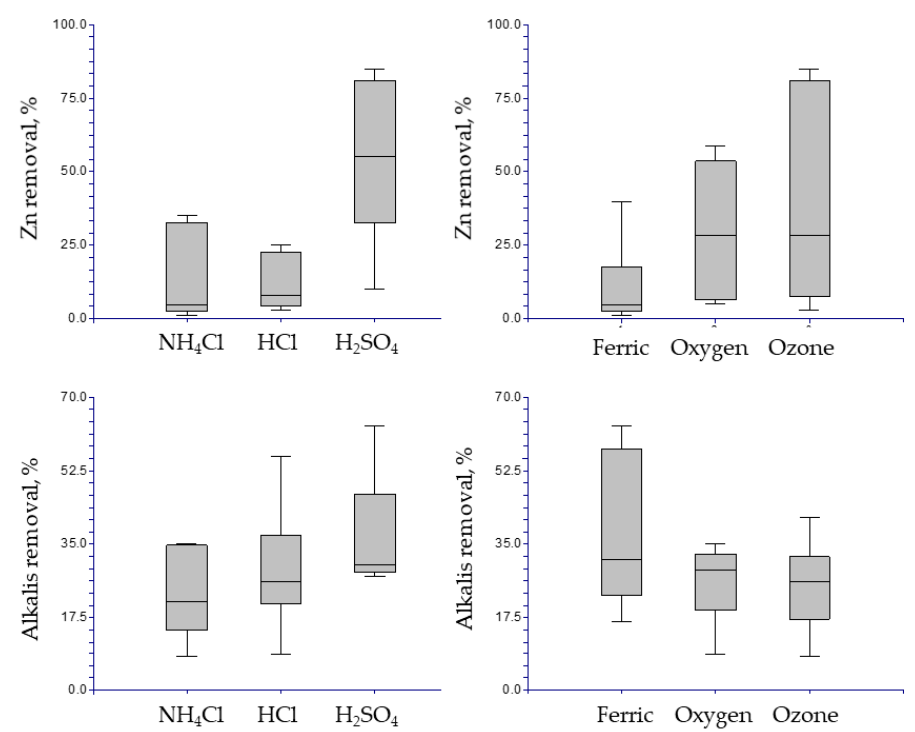
Figure 7. Box graphs for the individual effects of leaching media and oxidant in Zn and alkalis removal.